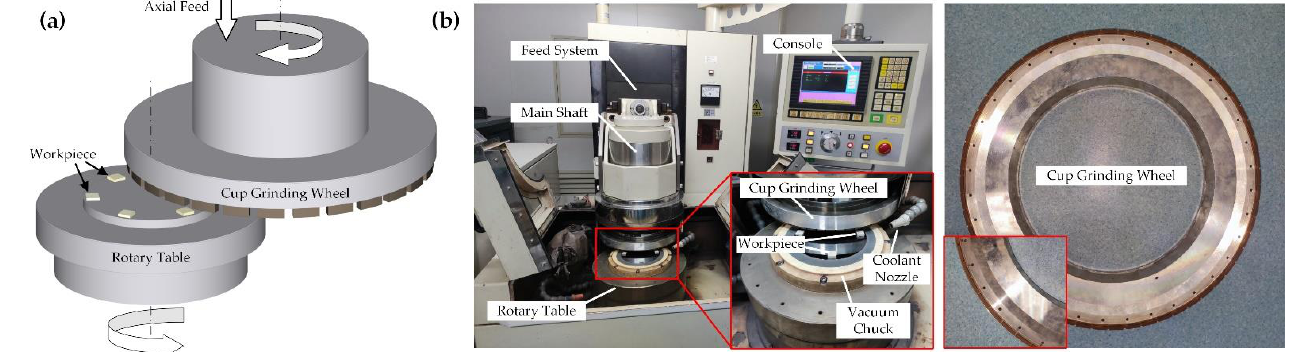
Figure 2. Grinding experimental setup: ( a ) schematic view of workpiece rotational grinding; ( b ) VG401 MK II workpiece rotational grinding machine and cup grinding wheel